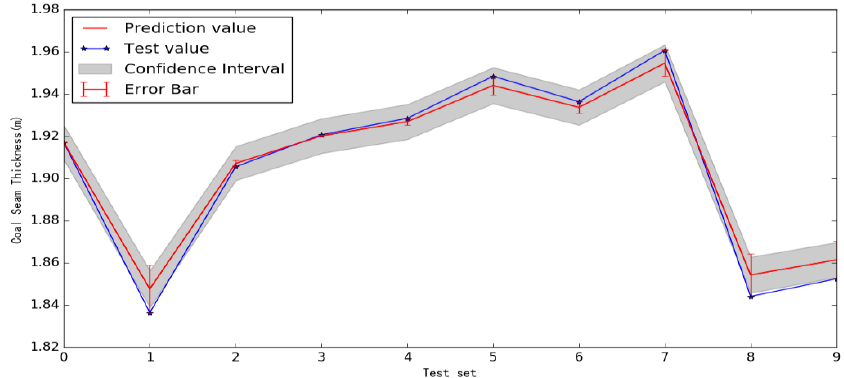
Figure 9. Test-Prediction Data Graph of improved algorithm.